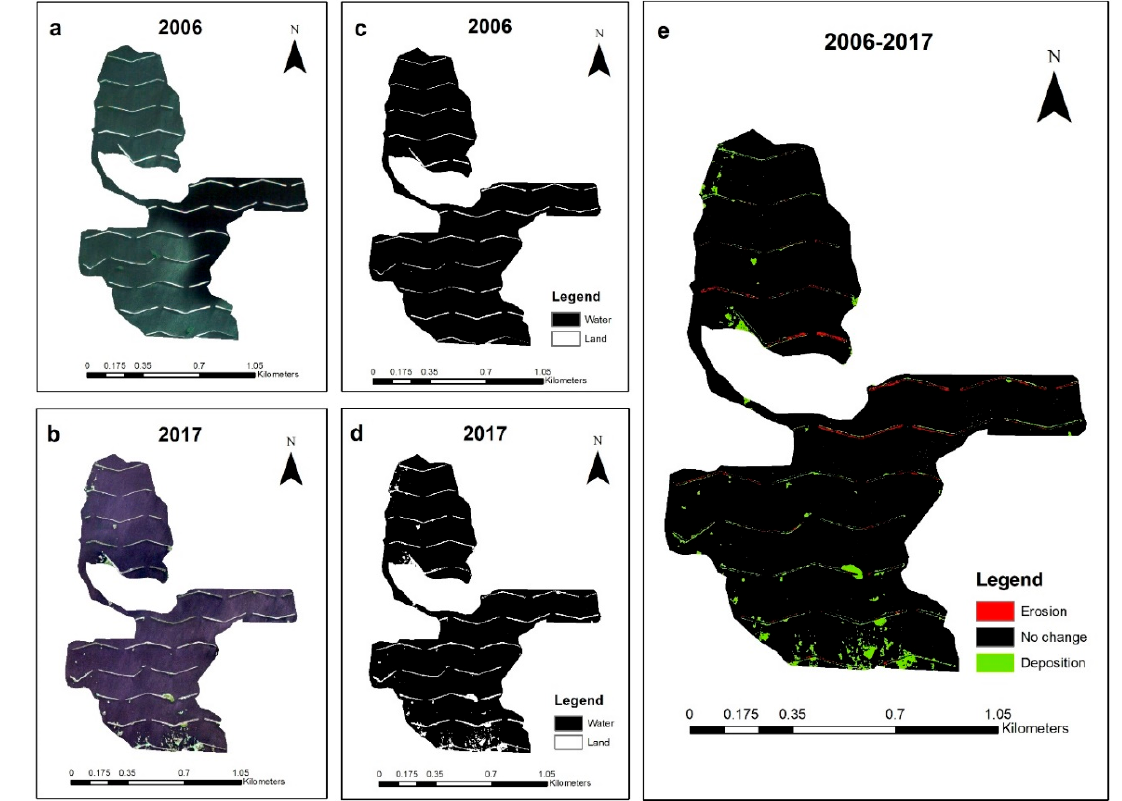
Figure 2. Analysis of a terrace field (C3) at Cameron Parish, LA. ( a ) Marsh terrace National Agriculture Imagery program (NAIP) imagery from 2006 showing the terraces recently built (where the white color is recently constructed and unvegetated terraces); ( b ) Marsh terrace NAIP imagery from 2017 showing the vegetated terraces (green color) after 11 years of establishment; ( c , d ) Marsh terrace land / water classified imagery from 2006 and 2017 respectively, where the white color represents the terraces and black color represents water within the polygon of analysis; ( e ) Change detection map from 2006–2017 where red color represents erosion, black is no change, and light green represent